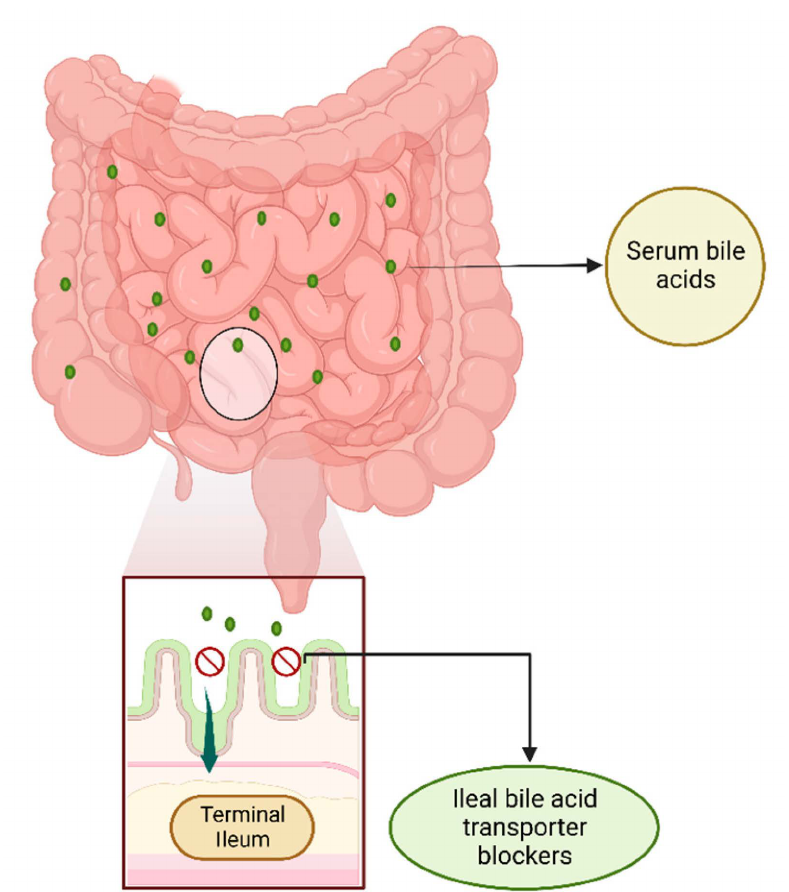
Figure 9. Ileal bile acid transporter (IBAT) blockers in the terminal ileum. Bile acids (BAs) are synthesized in the liver from cholesterol. Common Bas, such as cholic, deoxycholic, chenodeoxycholic, and lithocholic acid, may be combined with glycine or taurine to form conjugated BAs. Once excreted from the liver into the small intestine, most of the conjugated and unconjugated BAs are reabsorbed from the terminal ileum via the ileal bile acid transporter (IBAT) (or apical sodium-dependent bile acid transporter ( ASBT , SLC10A2 ). The BAs reenter the portal circulation with the sodium-dependent taurocholate co-transporting peptide (NCTP, SLC10A2 ) via the portal vein (not shown). IBAT blockers disrupt the enterohepatic circulation by preventing the uptake of primarily conjugated Bas, whereas unconjugated BAs may be taken back in the liver through organic anion transporters that are less